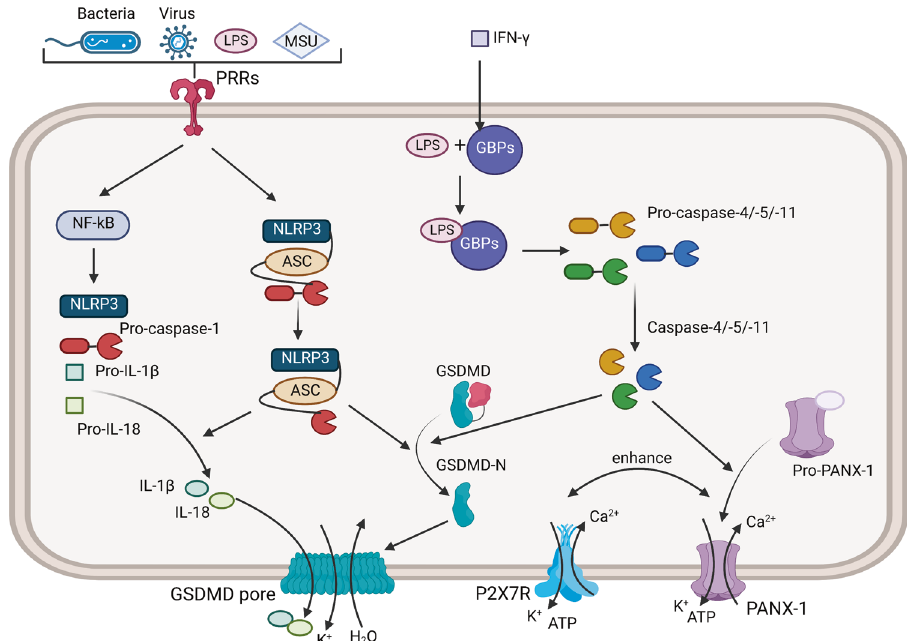
Fig. 1 Mechanisms of canonical/non-canonical pyroptosis pathway. Extracellular and intracellular signals like bacteria and virus protein, LPS, and MSU are detected by PRRs and activate NF-kB signaling to upregulate transcription of NLRP3, pro-caspase-1, and pro-IL-1 β /-18. Then NLRP3 in fl ammasome is assembled and activated. Caspase-1 cleaves GSDMD, and the N-terminal generates membrane pores which induce cytotoxicity. Pro-caspase-1 β /-18 is also cleaved by caspase-1, and mature cytokines are released through membrane pores. The non-canonical pathway is triggered by intracellular LPS, which activates caspase-4/-5/-11 with the help of GBPs. Activated caspase-4/-5/-11 cleaves GSDMD and pro-pannexin-1 and contributes to membrane pore formation. Pannexin-1 pore has a mutual promoting effect with P2X7 pore, and they lead to K + and ATP ef fl ux and Ca 2 + in fl ux